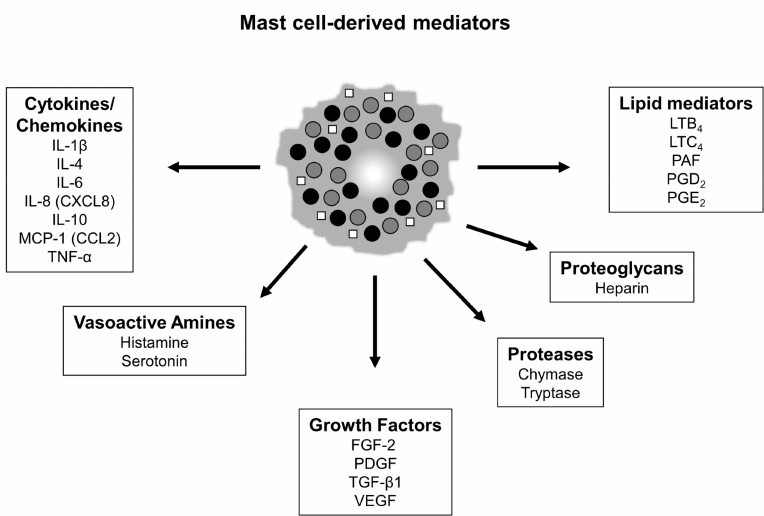
Figure 1. Notable mast cell mediators. Mature mast cells can secrete a wide array of mediators that are either pre-made and stored in granules or are synthesized upon activation. Mediators can be secreted from mast cells through the release of granules (filled circles) or the release of secretory vesicles (open squares). (Note: this is not a complete list of mast cell